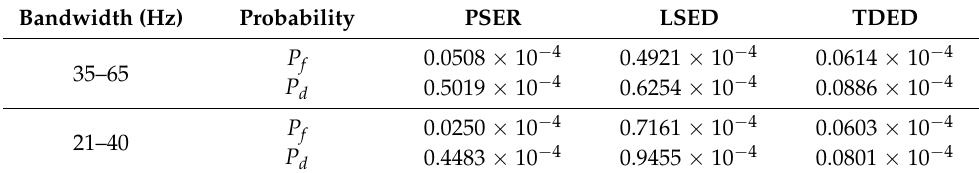
Table 2. MSEs between actual and theoretical probabilities for the Ricker wavelet.